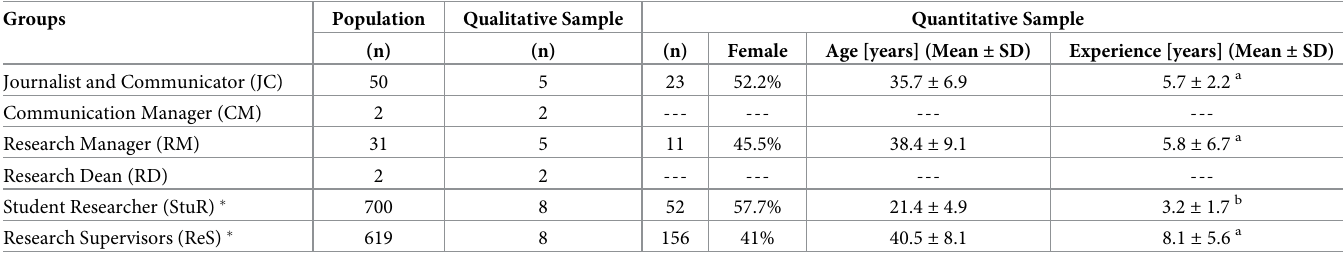
Table 1. Subjects participating in the